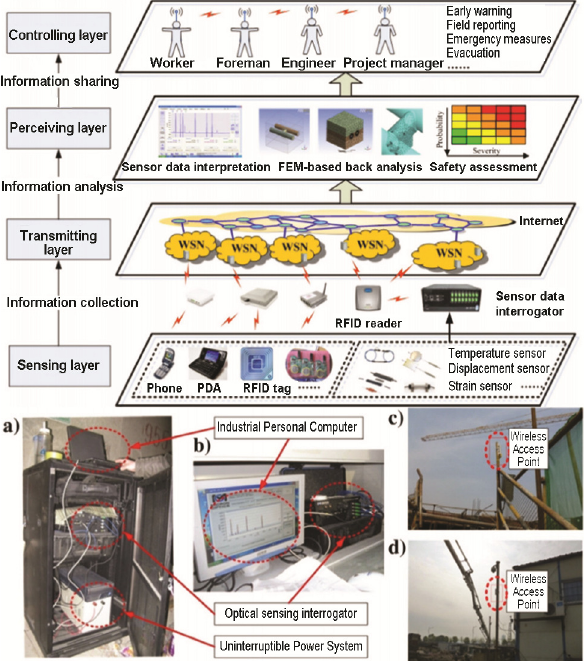
Fig. 8. Architecture of IoT-based safety early warning system and transmitting devices at the construction site (Ding et al. 2013b)